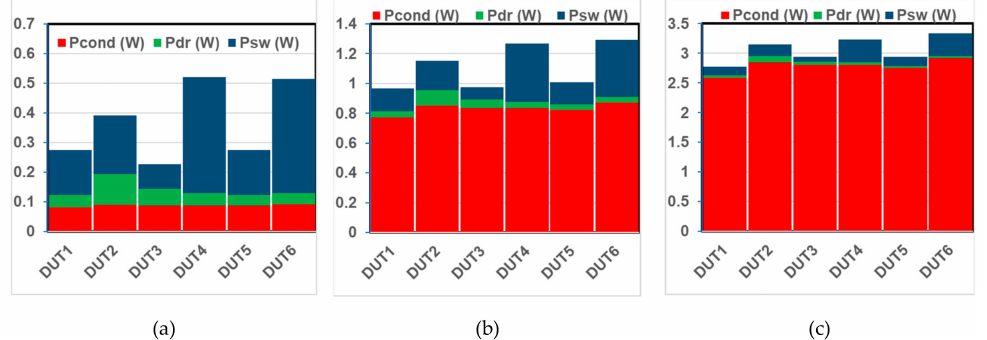
Figure 10. Measured power losses owing to driving (P DR ), switching (P SW ), and conduction (P ON )